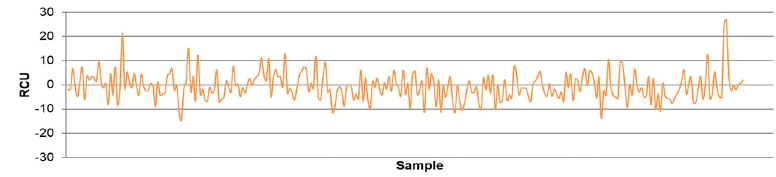
Figure A35. Prediction error of NN2 model testing dataset.